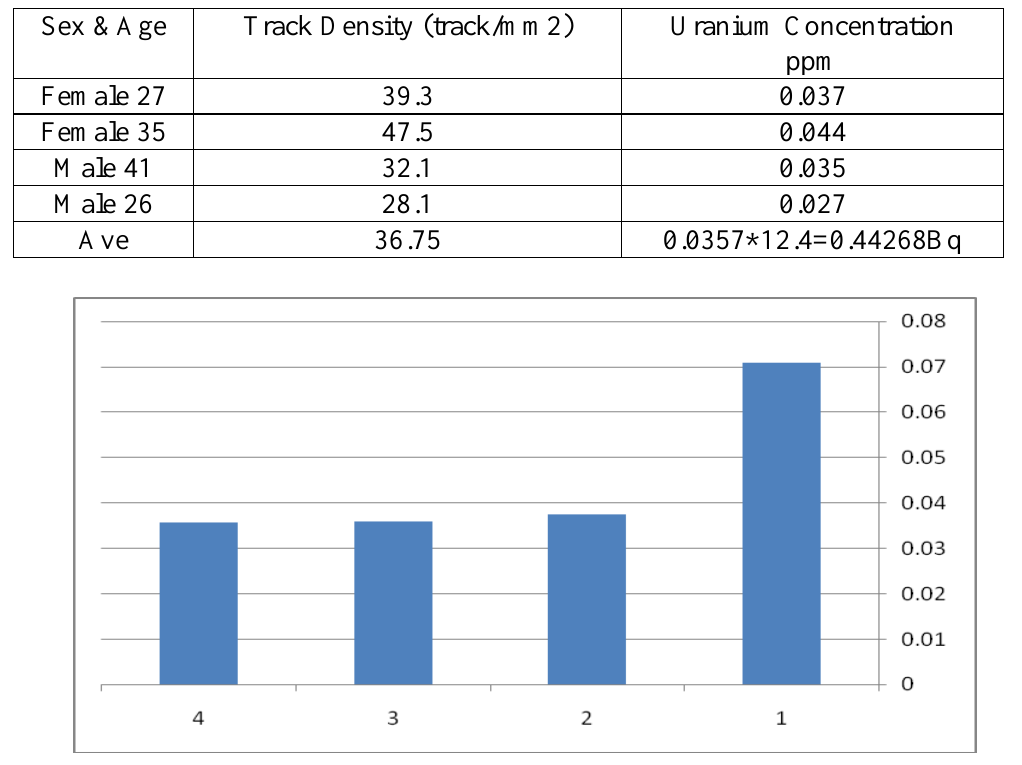
Fig. 3: Compare Between (max& min) of Uranium concentration in teeth